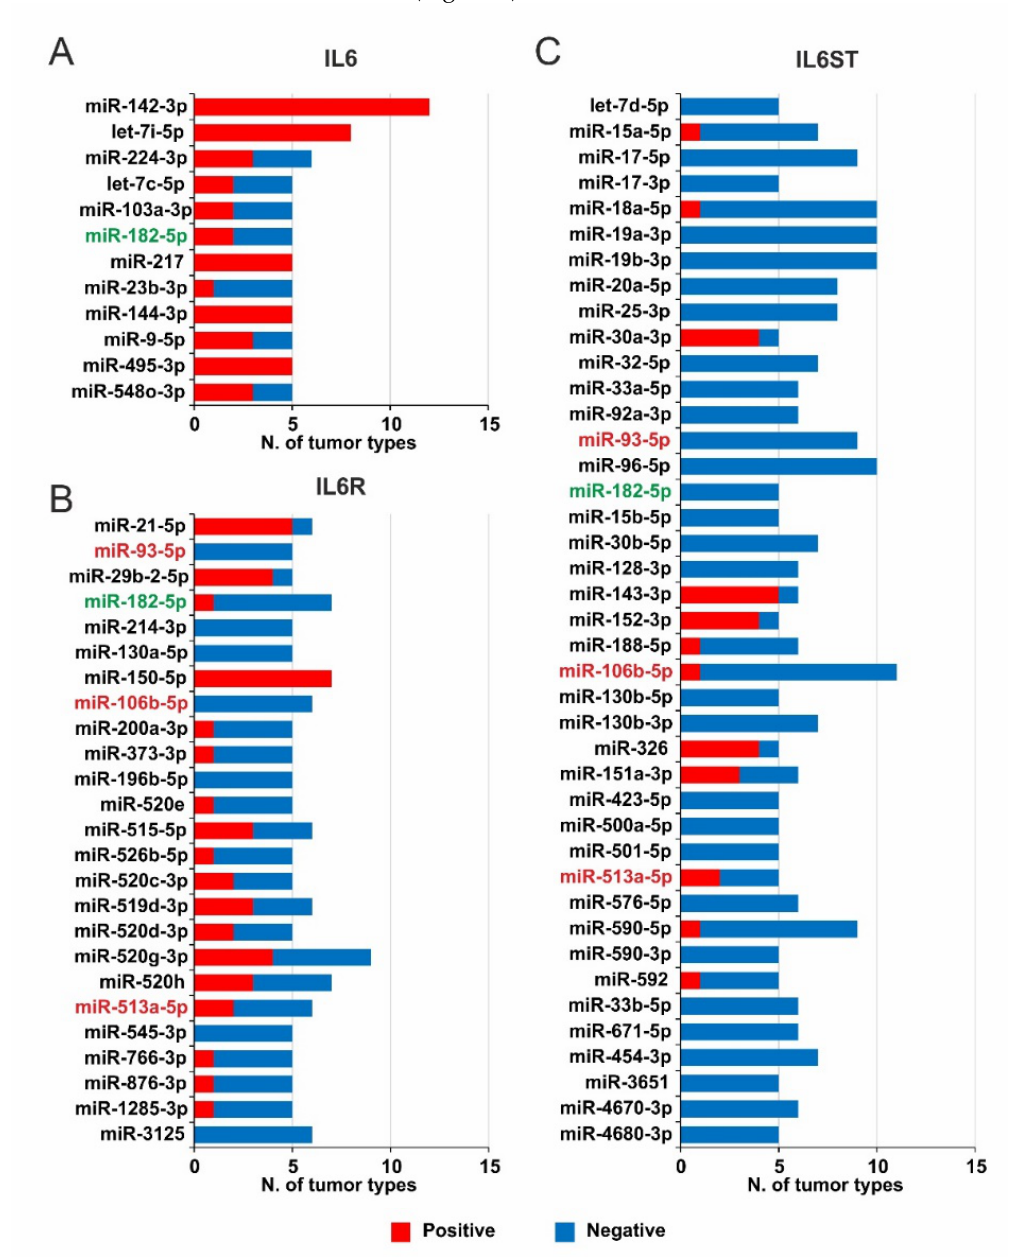
Figure 5. Overview of selected miRNAs correlated with the expression of IL6, IL6R, and IL6ST. The number of miRNAs targeting IL6 ( A ), IL6R ( B ), and IL6ST ( C ) (mirDIP class score: high/very high) was evaluated in all TCGA tumor types. The miRNAs with Pearson’s r ≤ −0.3 or ≥ 0.3 ( p ≤ 0.05) in at least 5 different tumor types are shown. It is reported, in green font, the miRNAs shared among IL6, IL6R, and IL6ST, whereas in red font those correlated to both IL6R and IL6ST.